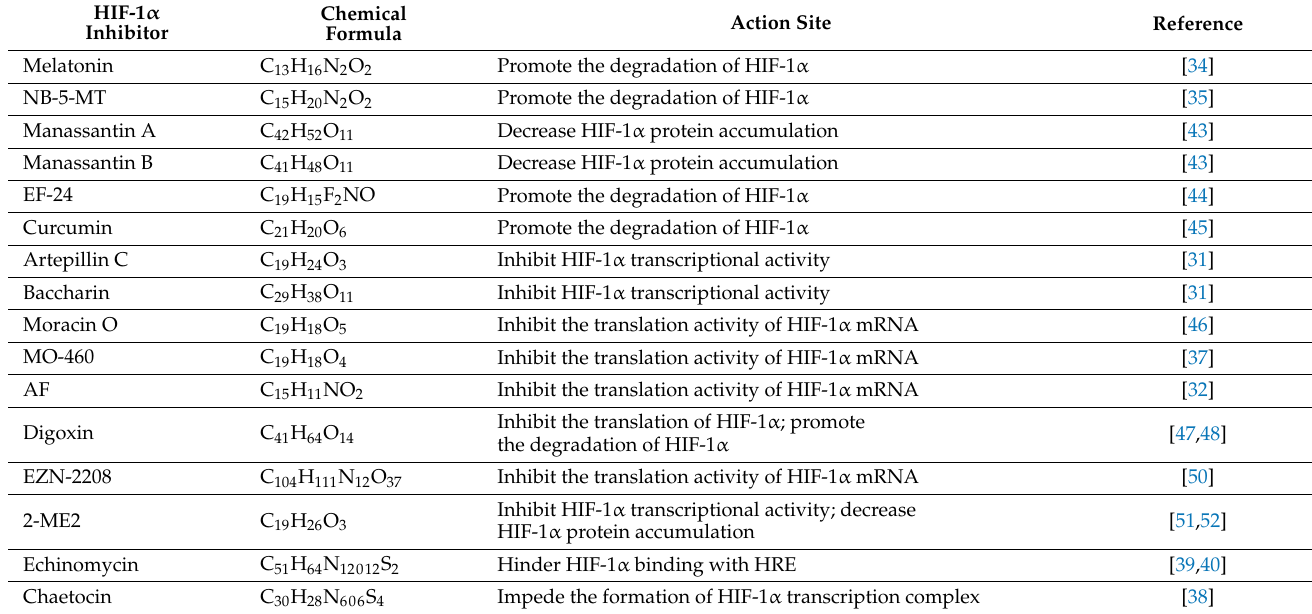
Table 1. Action Sites of HIF-1 α